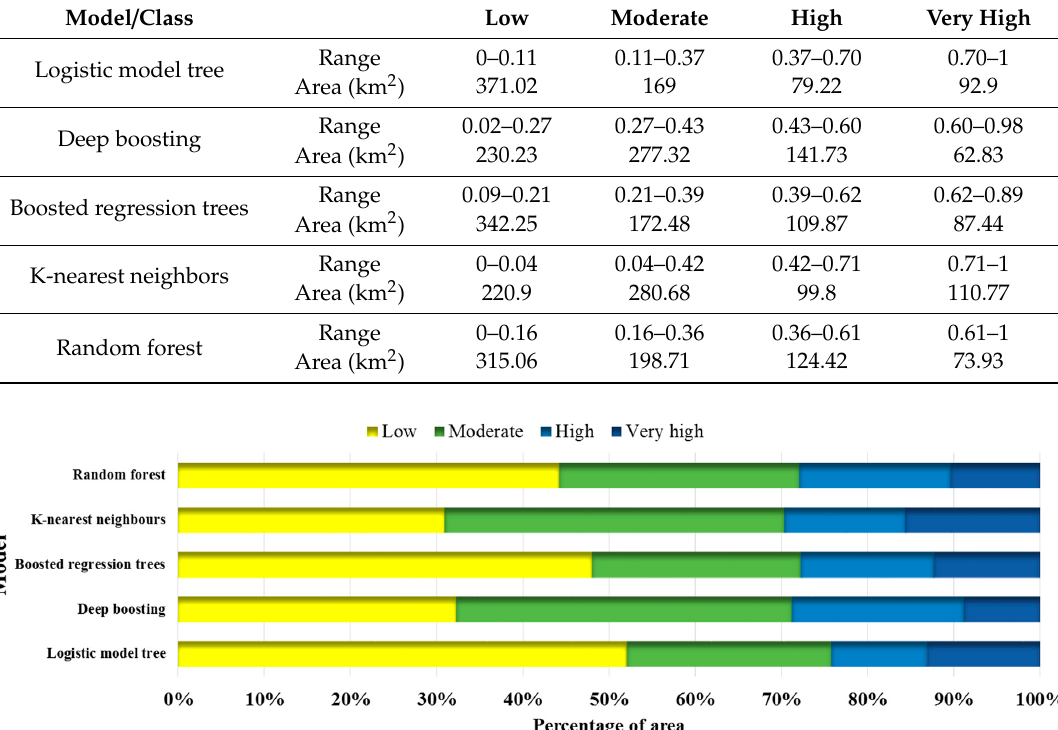
Figure 10. Percentage of each class of the GW potential maps constructed by the logistic model tree, deep boosting, boosted regression trees, and k-nearest neighbors.